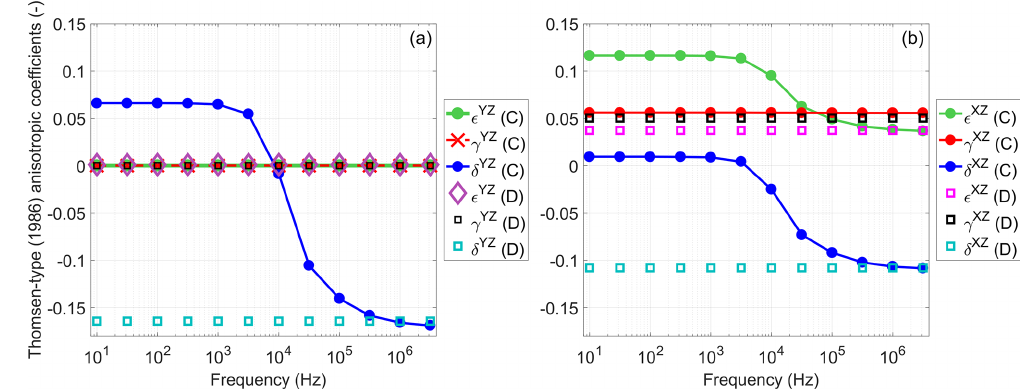
Figure 8. Thomsen-type anisotropic parameters in the Y – Z (a) and X – Z (b)